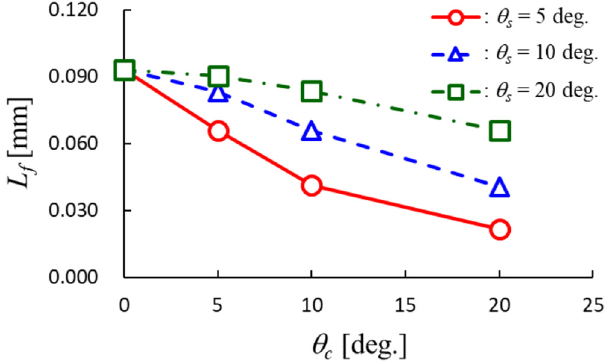
Fig. 11. In fl uence of u s and u c on L f